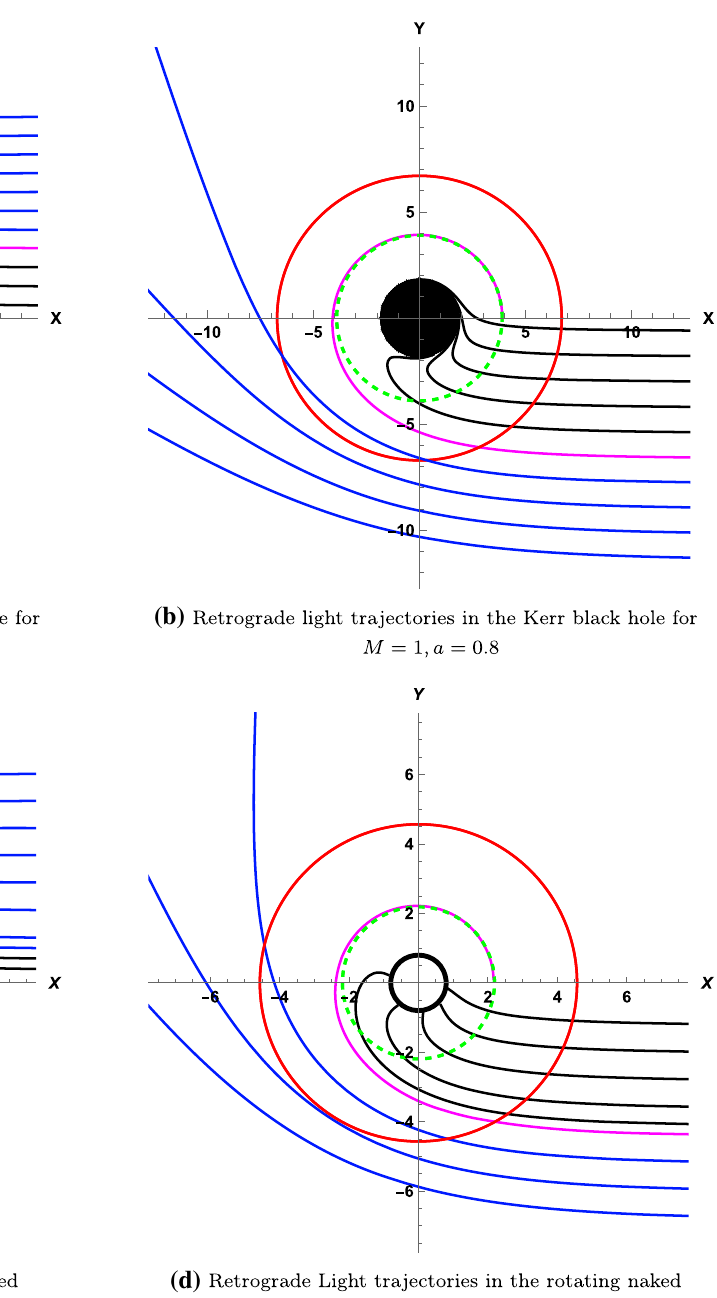
by blue, and those plunging into the compact object are denoted by black. The light rays denoted by pink correspond to the critical impact parameter. In a , b , the black shaded regions at the centre represent the outer event horizon of the Kerr black hole. Whereas in c , d , the central black rings correspond to the ring